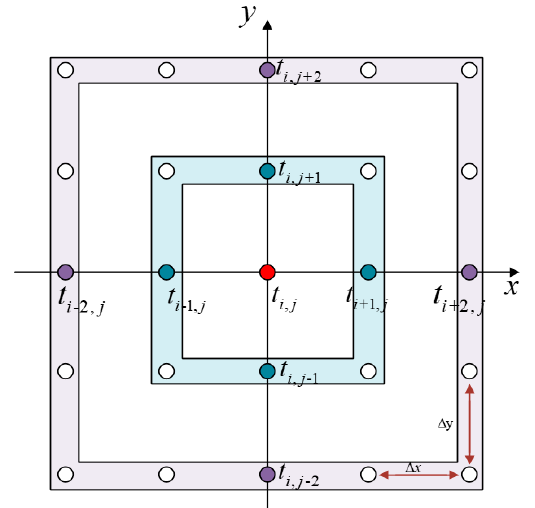
Figure 4. The point distribution for the calculation of the guided wave flight time. At most eight points of travel time information is required in second-order difference form.